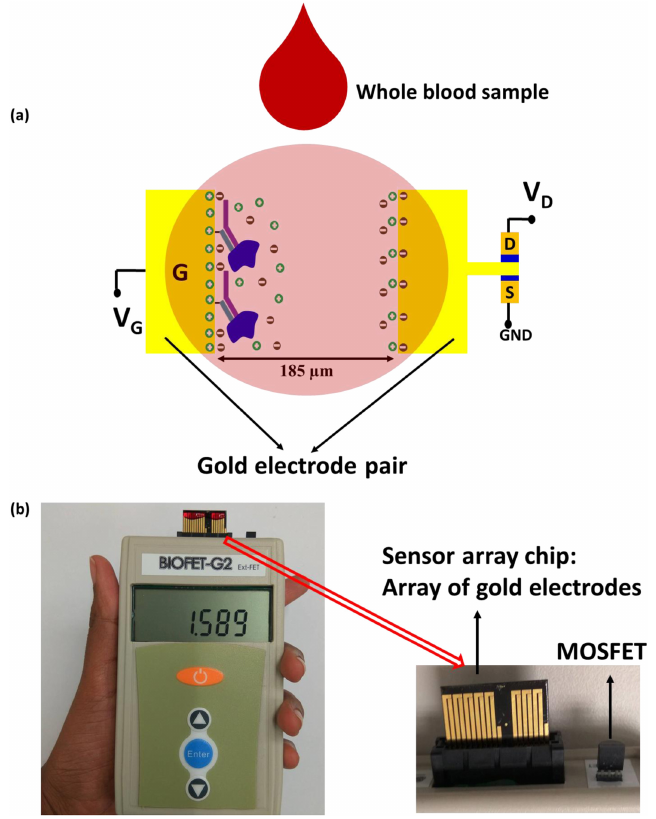
Figure 5. Extended gate electric double layer (EDL) FET biosensor [80]. ( a ) schematic illustration of the biosensor; ( b ) real image of the hand-held measurement system integrating the sensor array